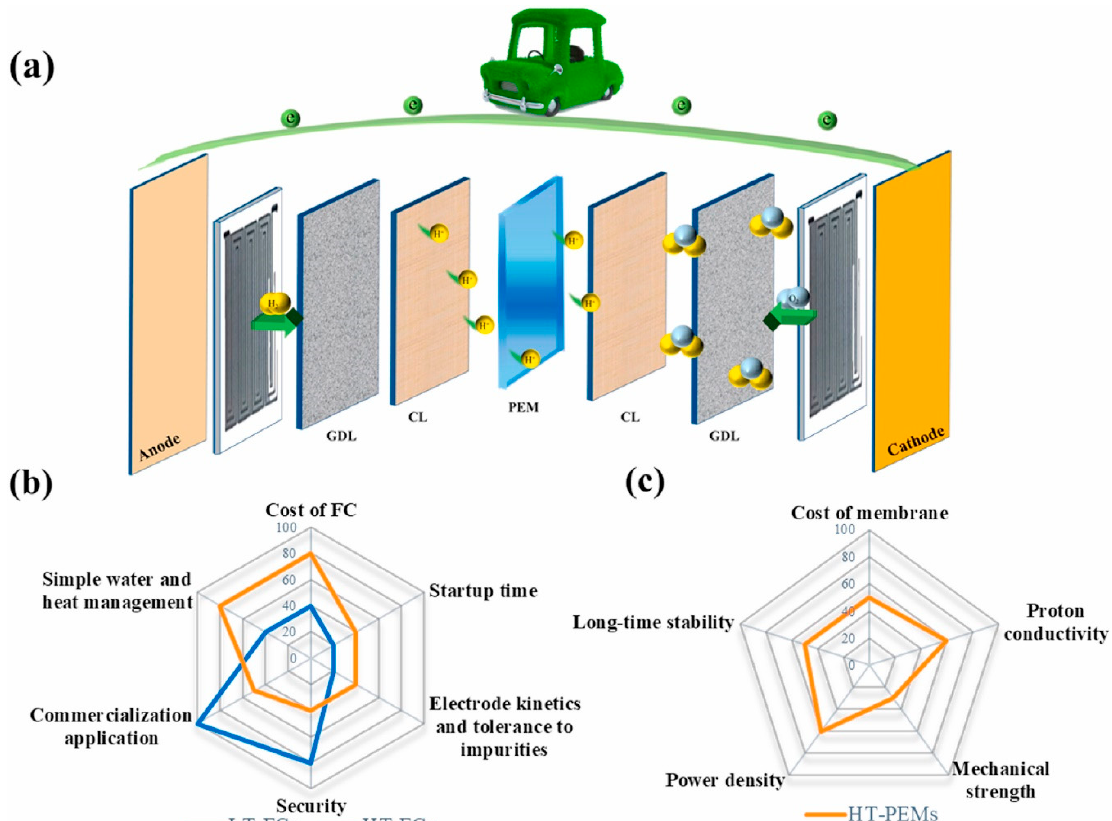
Figure 9. ( a ) A general structure of a PEMFC, ( b ) comparison of LT-PEMFCs and HT-PEMFCs, ( c ) property spider charts of HT-PEMs [79]. Republished with permission from Elsevier (License no: 5398690259427).